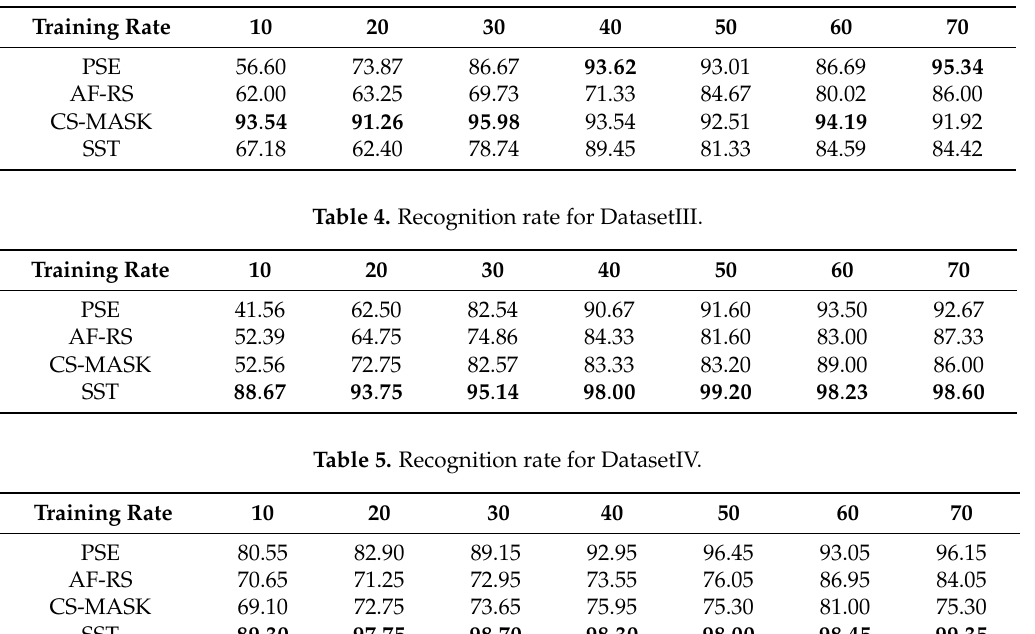
Table 3. Recognition rate for DatasetII.